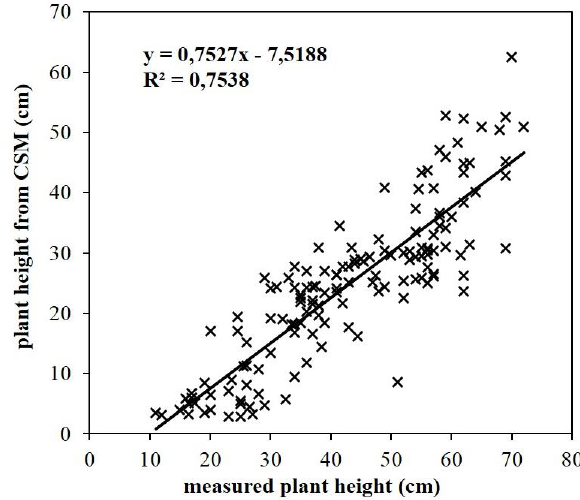
Figure 5: Regression of plant heights from CSM and in-field measurements (n = 144)